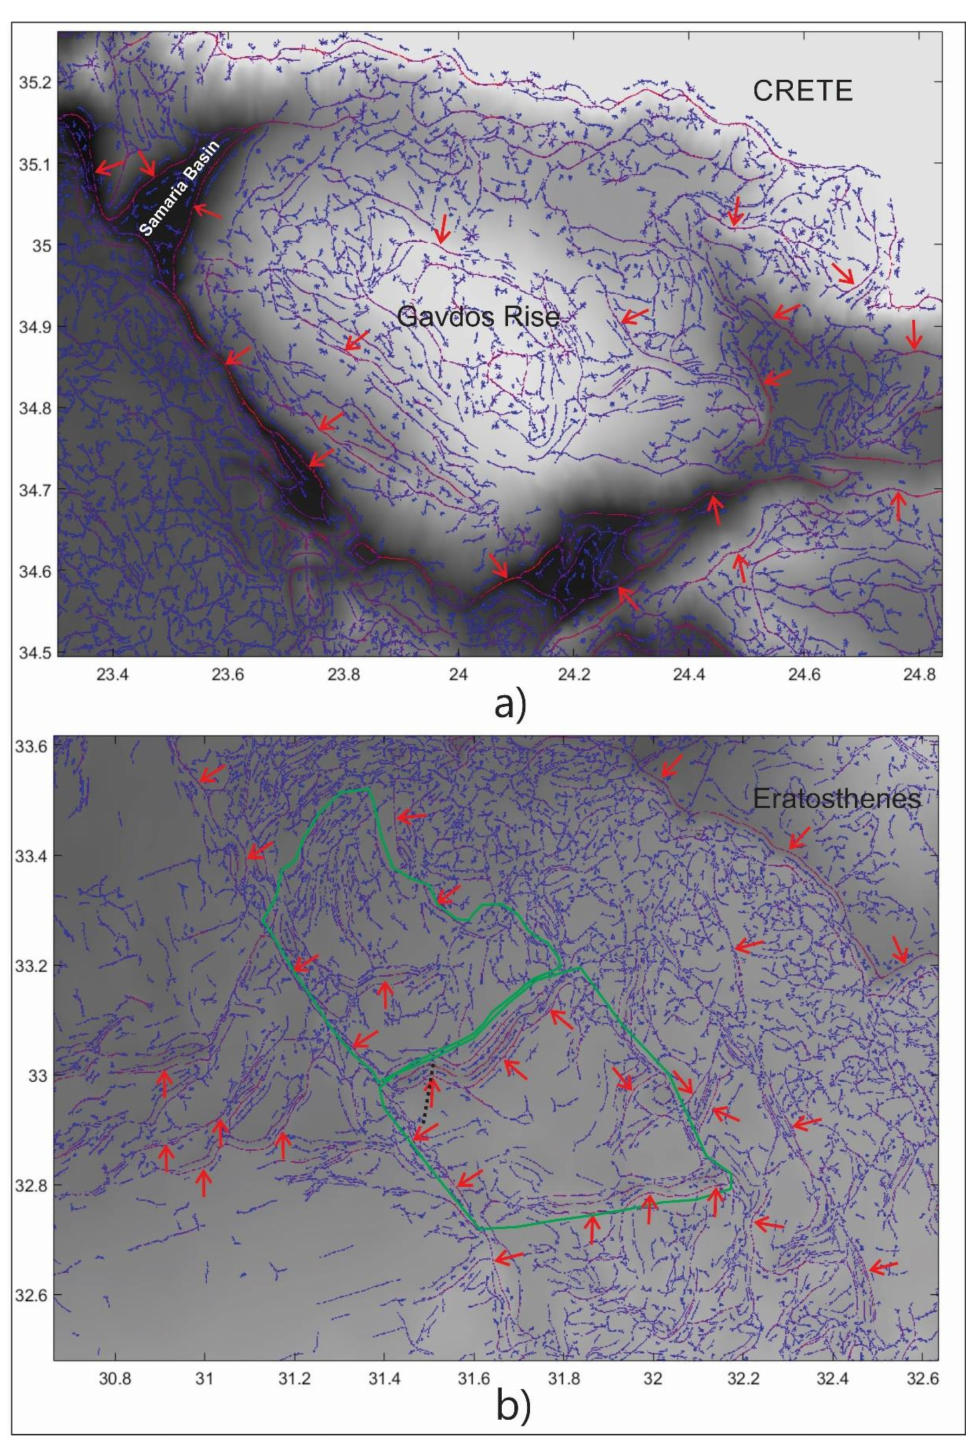
Figure 5. Comparison of the automatically detected linear and curvilinear elements with ground truth data. The red lines correspond to strongly detected linear and curvilinear elements, while the blue lines correspond to weak ones. Red arrows show the linear and curvilinear elements corresponding to strong automatic detection and they are in full agreement with previously reported geological faults in ( a ) the wide area of Gavdos Rise in South Crete [43–45] and ( b ) southwest of the Eratosthenes Seamount. Areas indicated by the closed green line are possibly a ff ected by shallow salt movements